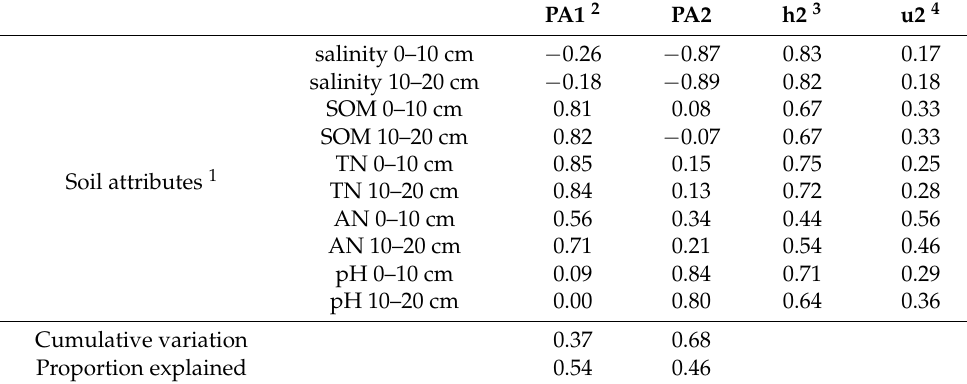
Table 2. Results of the explanatory factor analysis for soil